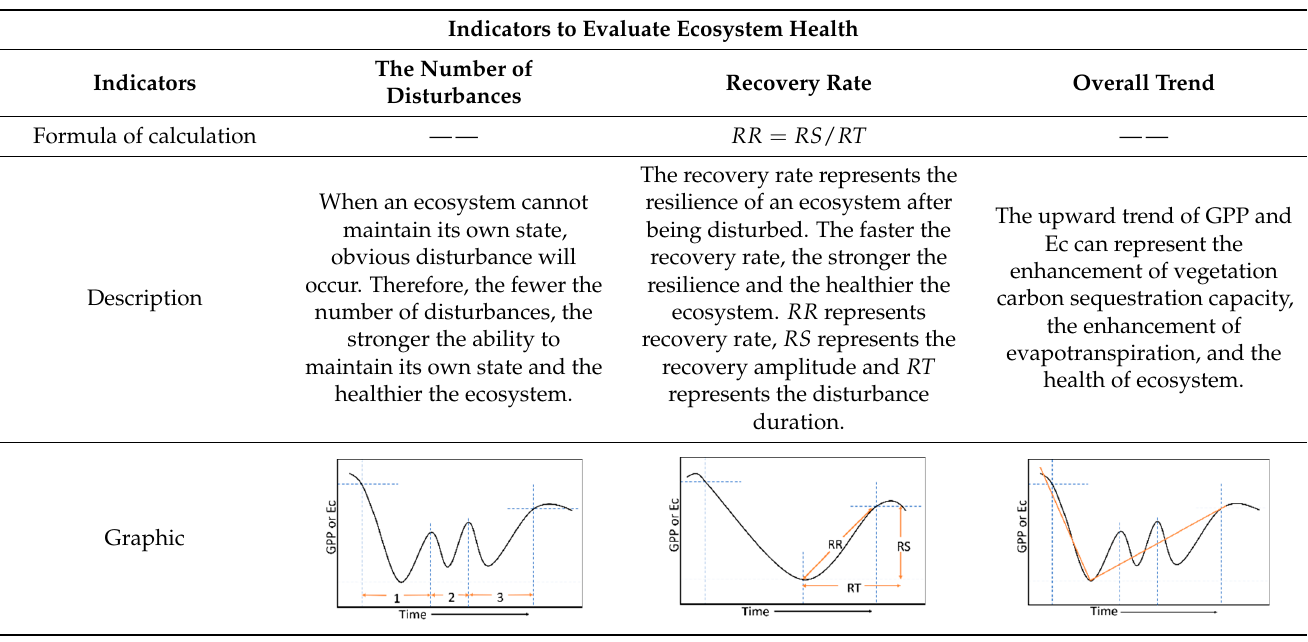
Table 2. Indicators used to evaluate ecosystem health based on GPP and Ec time series.